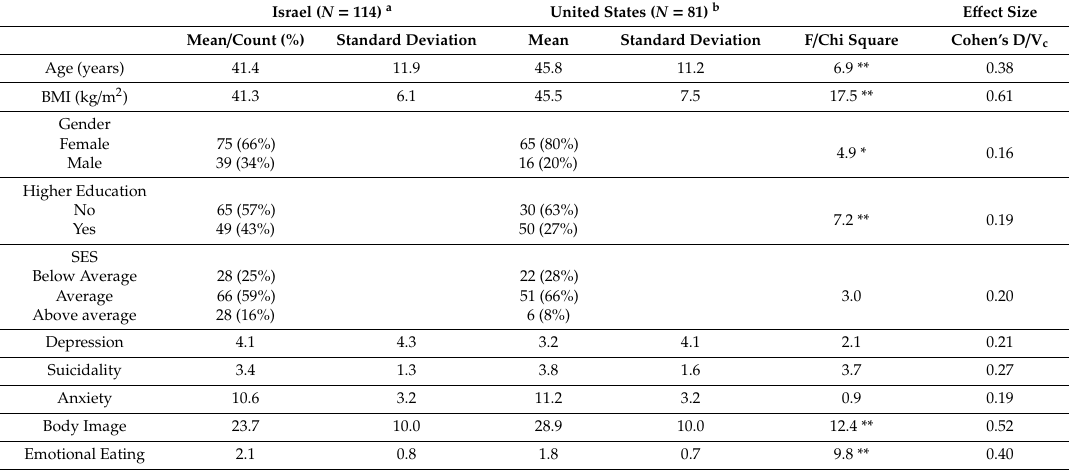
Table 1. Sample di ff erences in demographic and study variables. Categorical outcomes are described as count (%) and were compared using the Chi-square test. Continuous variables are described by means and standard deviations and were compared using the F test (one way ANOVA).